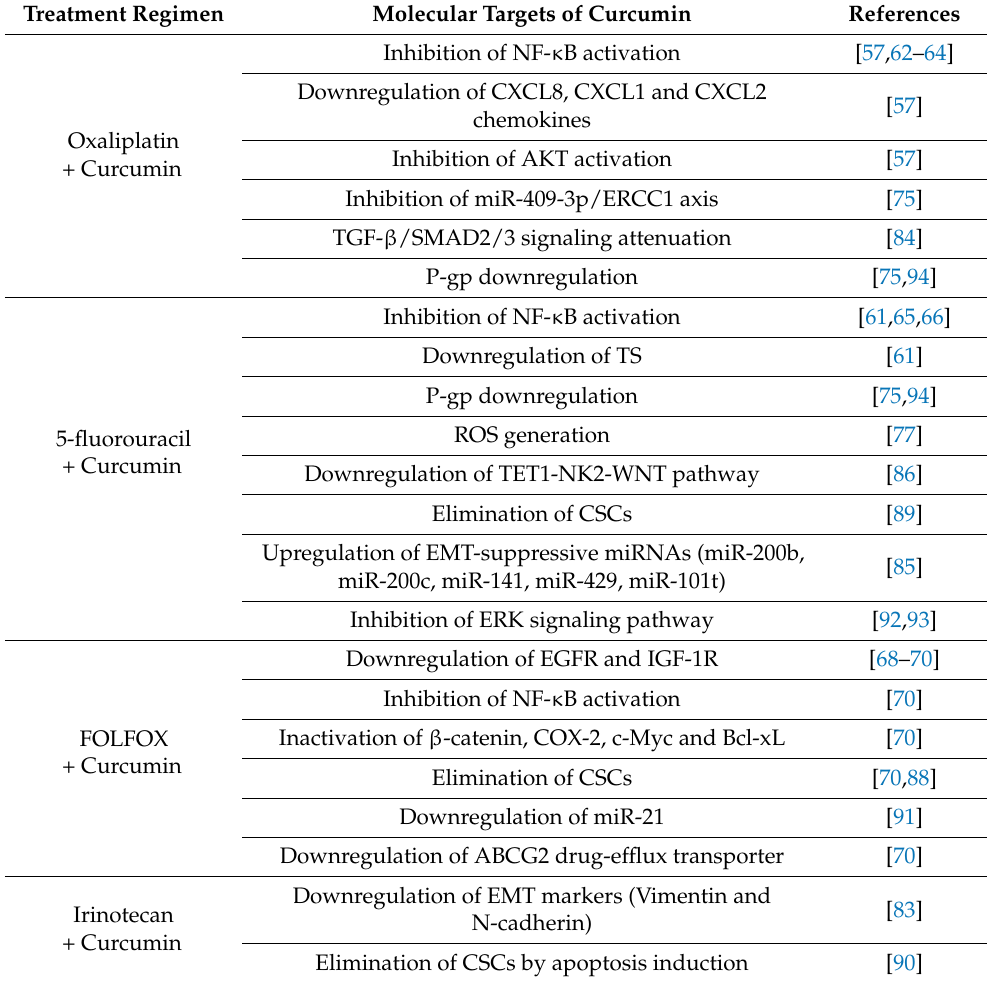
Table 1. Main molecular mechanisms of action of the combination of curcumin and chemotherapeutic agents in preclinical models of CRC. ABCG2: ATP-binding cassette transporter G2; CSCs: cancer stem cells; EGFR: epidermal growth factor receptor; EMT: epithelial-to-mesenchymal transition; IGF-1R: growth factor-1 receptor; NF- κ B: nuclear factor kappa B; P-gp: P-glycoprotein; ROS: reactive oxygen species; TGF- β : transforming growth factor β ; TS: thymidylate